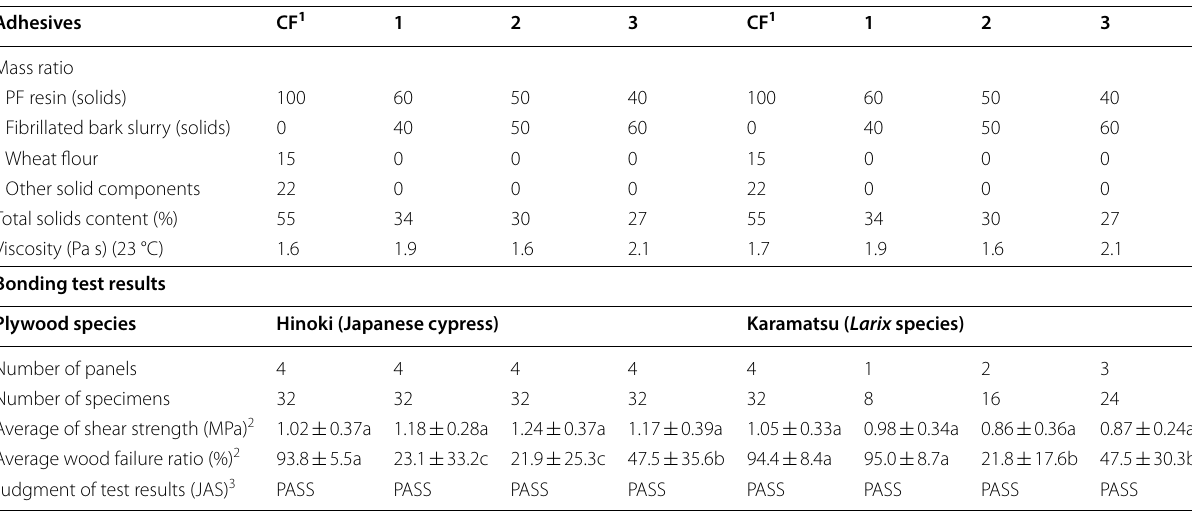
Table 3 Fibrillated bark slurry adhesive composition and bonding qualities of hinoki and karamatsu plywoods from the continuous 72-h boiling test